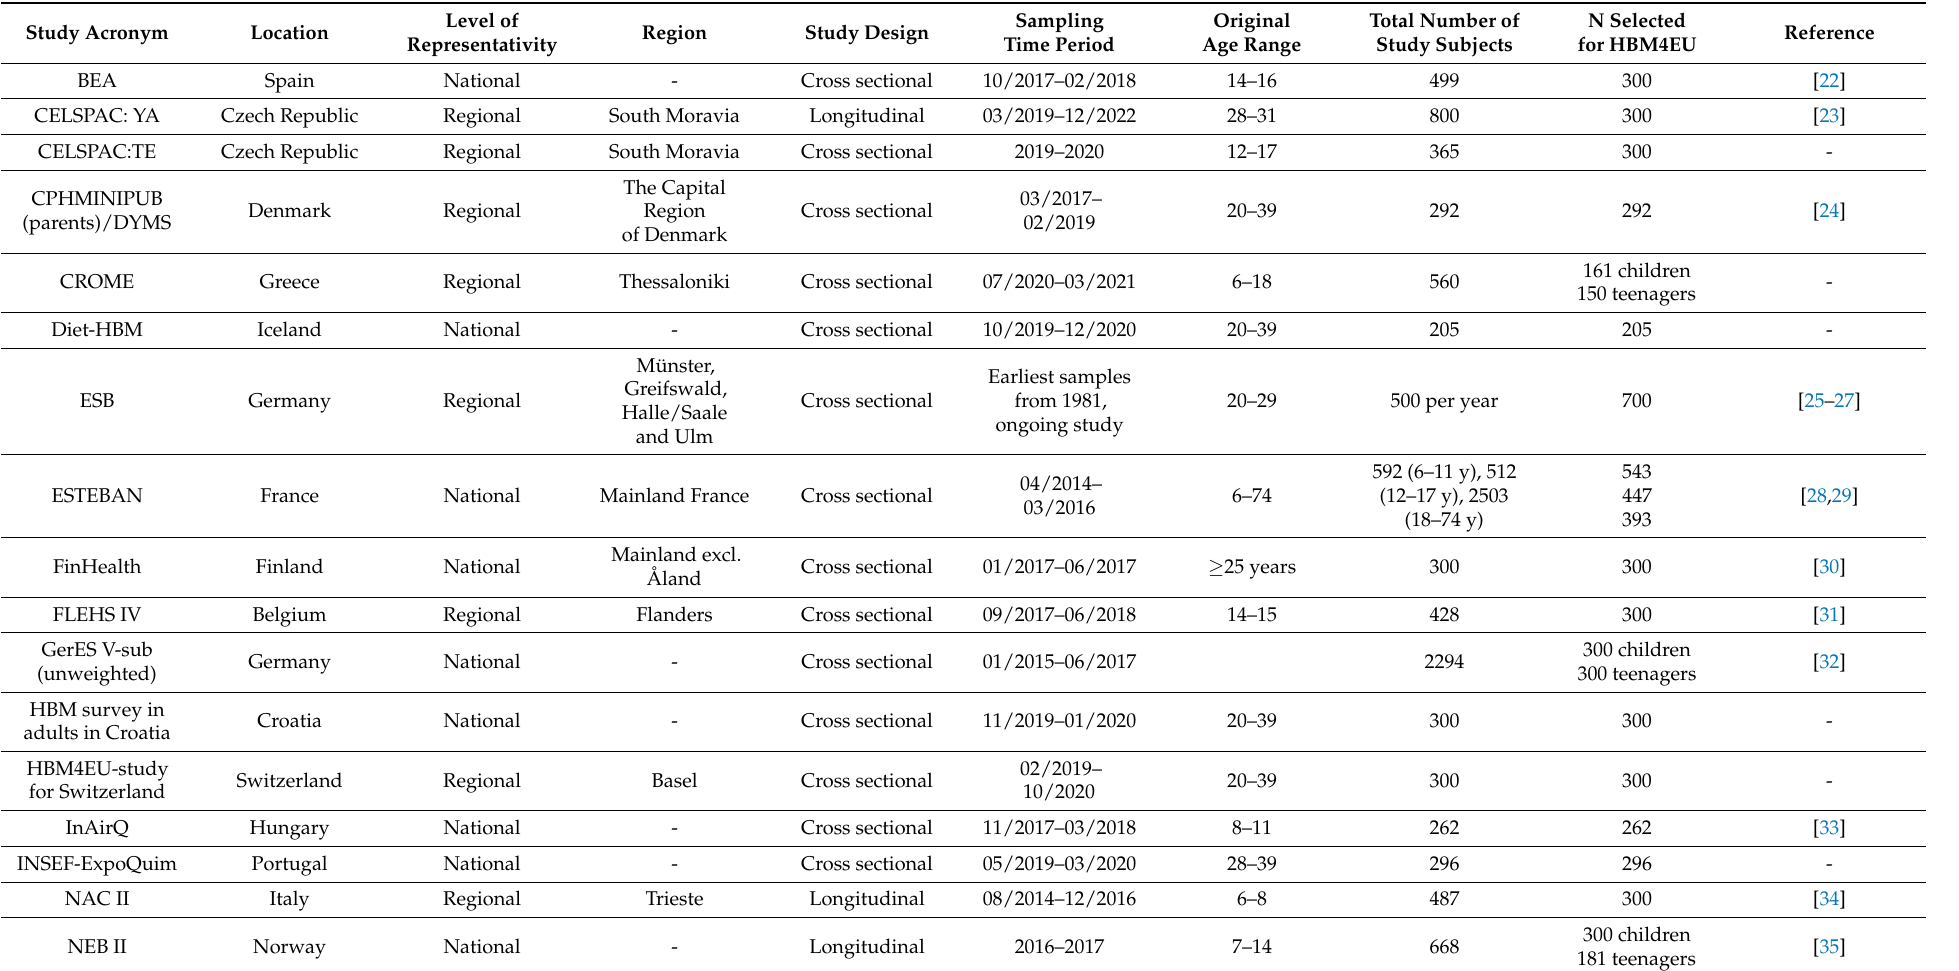
Table 1. Characteristics of studies contributing to the HBM4EU-aligned